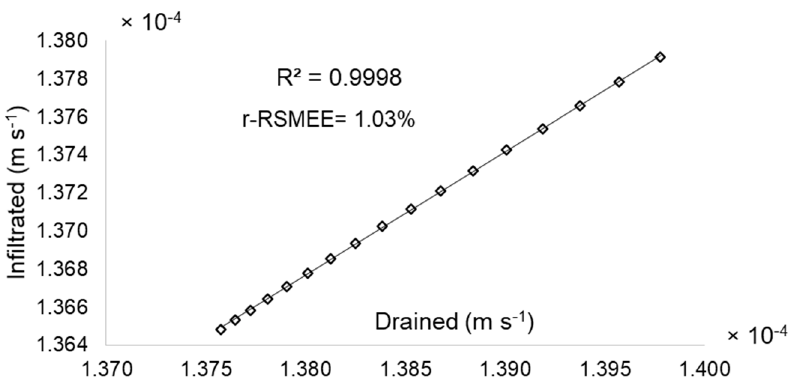
Figure 10. Correlation between Infiltrated water flux rates and Drained water flux rates.